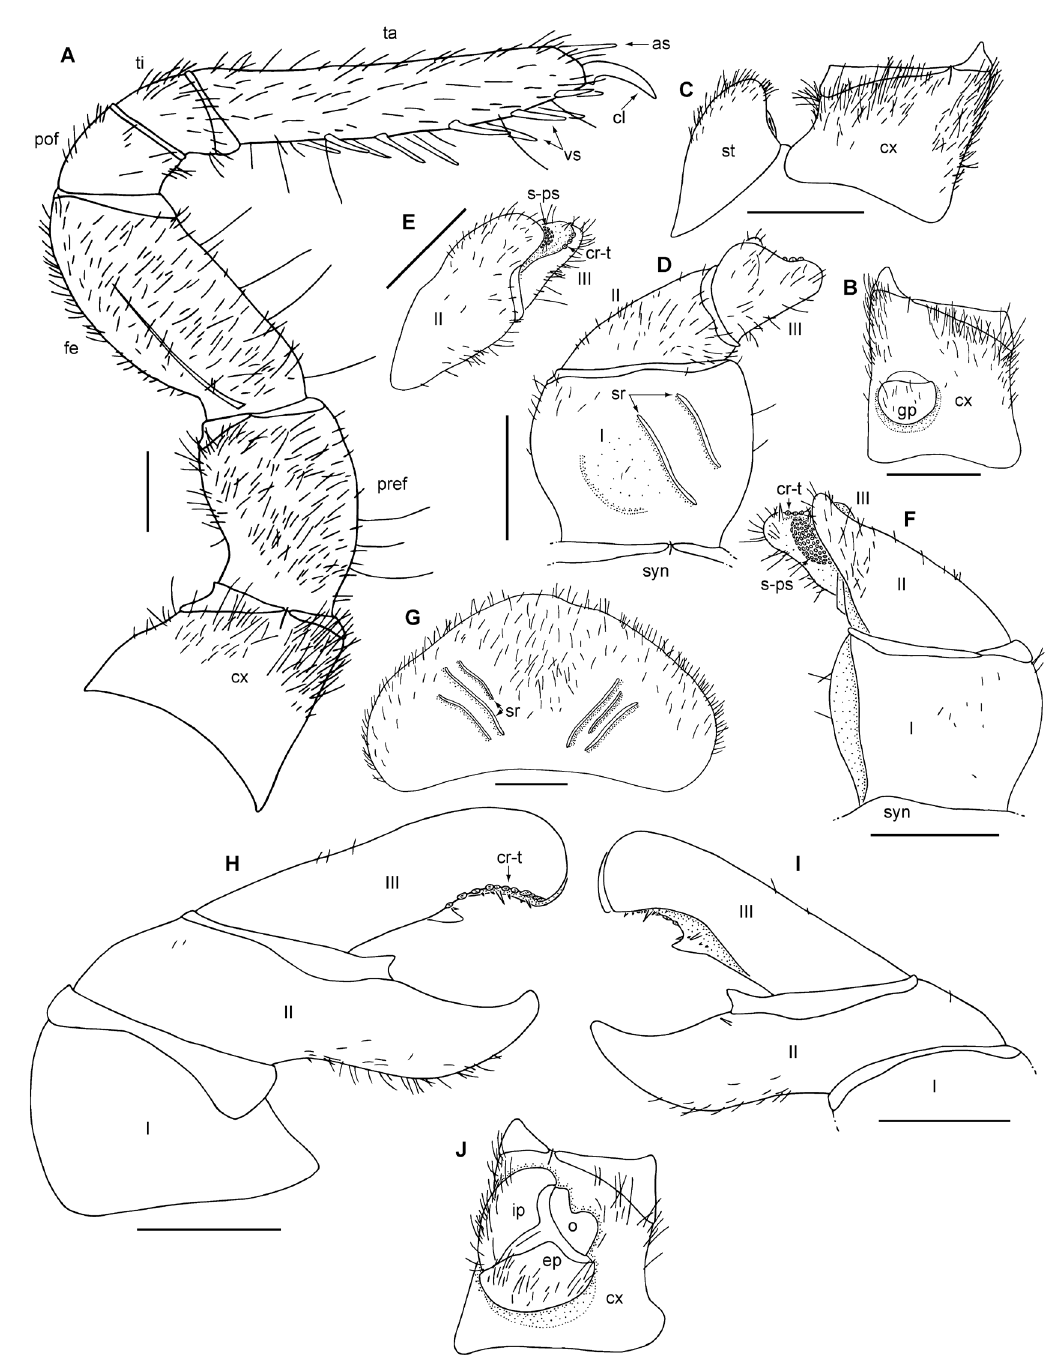
Fig. 12. Zoosphaerium spinopiligerum sp. nov., holotype (FMNH-INS 3119885). A . Right leg 9, posterior view. B . Left coxa 2 with gonopore, posterior view. C . Right coxa 1 with stigmatic plate, posterior view. D . Left anterior gonopod, anterior view. E . Left anterior gonopod, lateral view. F . Left anterior gonopod, posterior view. G . Female subanal plate with washboard. H . Right posterior telopod, posterior view. I . Right posterior telopod, anterior view. J . Left female coxa 2 with vulva, posterior view. Abbreviations: as = apical spine; cl = claw; cr-t = crenulated teeth; cx = coxa; ep = external plate; fe = femur; gp = gonopore; ip = inner plate; o = operculum; pof = postfemur; pref = prefemur; s-ps = sclerotized spots; sr = stridulation rib; st = stigmatic plate; syn = syncoxite; ta = tarsus; ti = tibia; vs = ventral spines. Roman numerals indicate telopoditomeres. Scale bars = 1